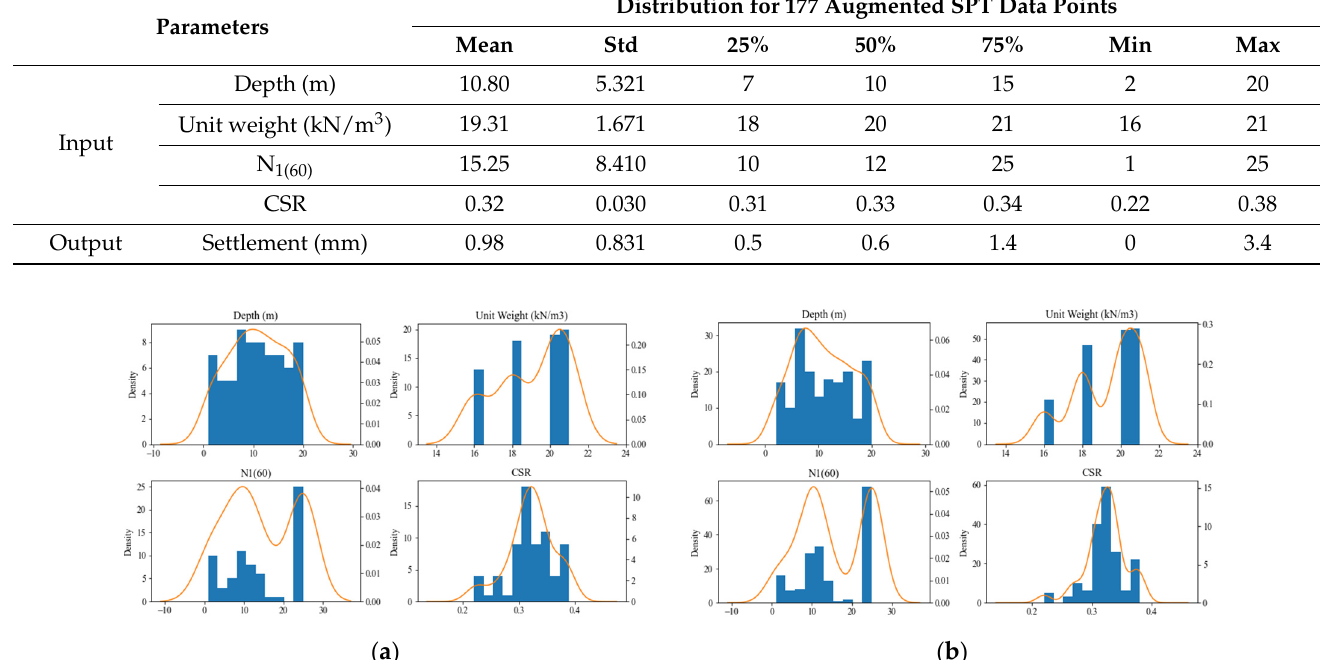
Table 2. Augmented data points.